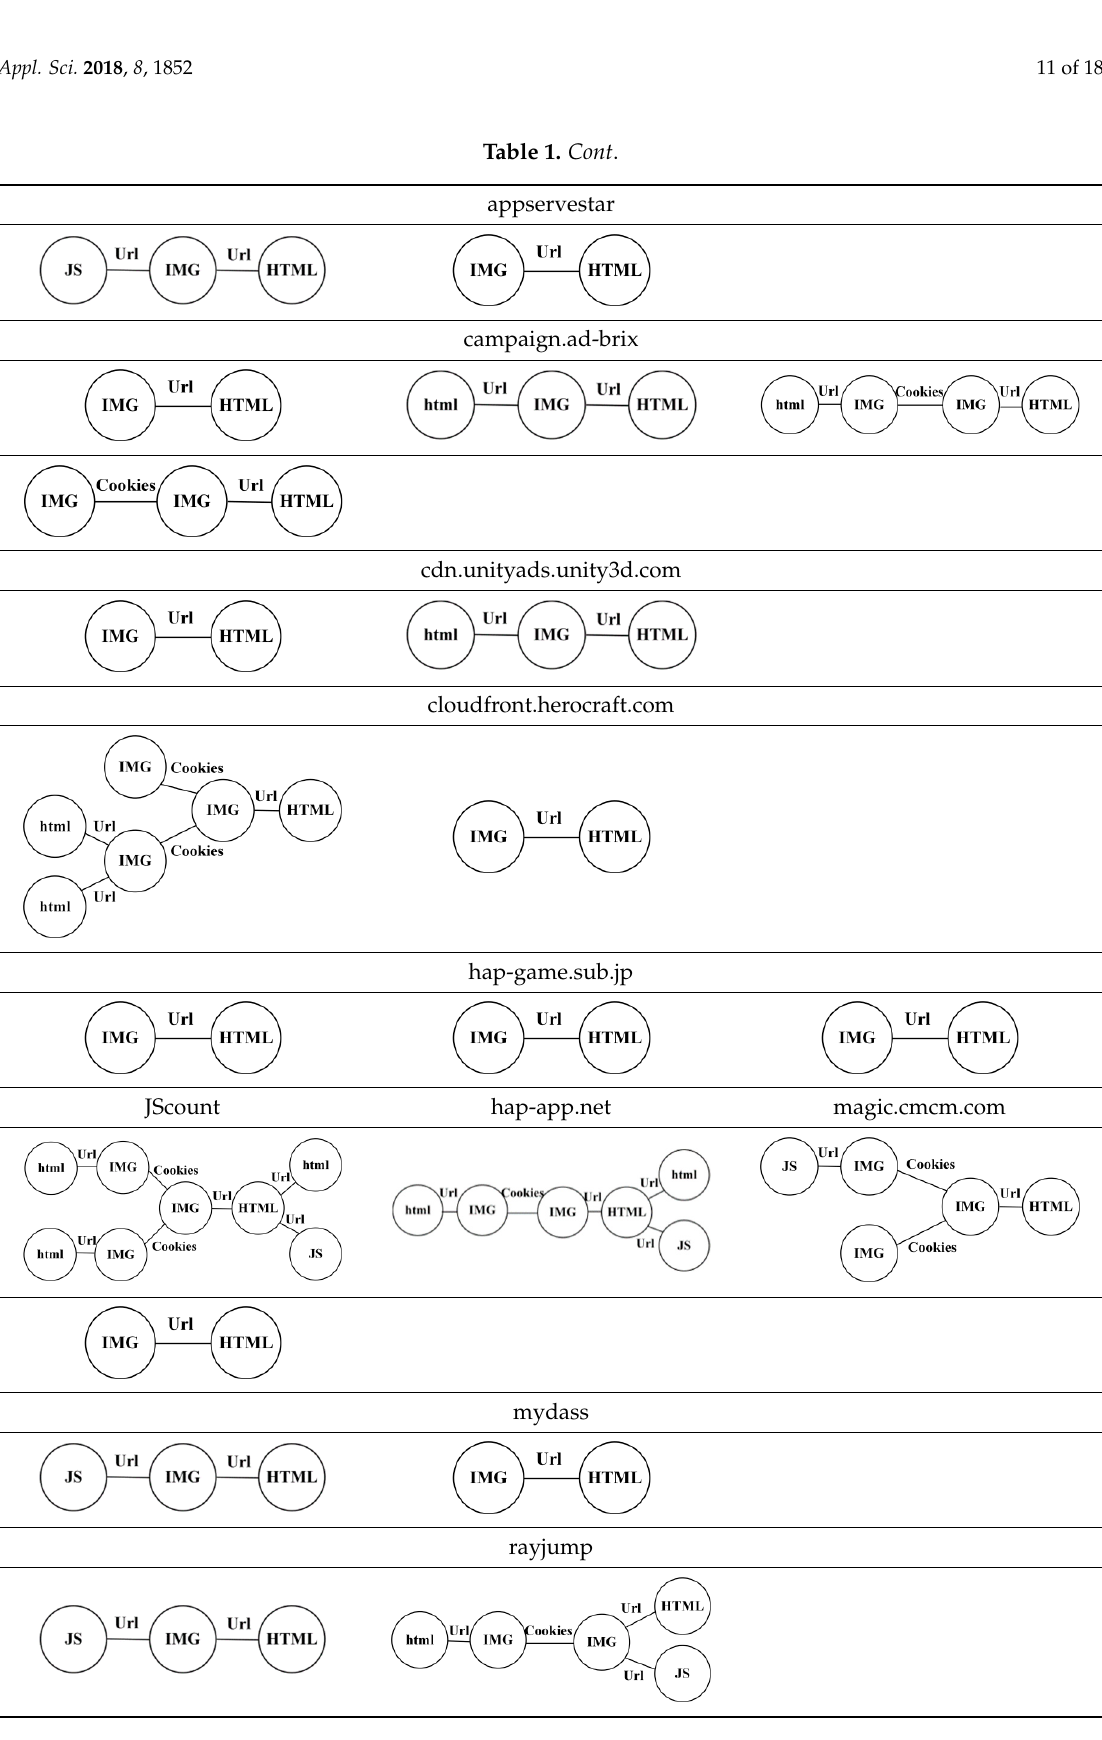
Figure 5. Ad libs’ network behaviors and their graph representations ( a ) MoPub, ( b ) Mmate, ( c )